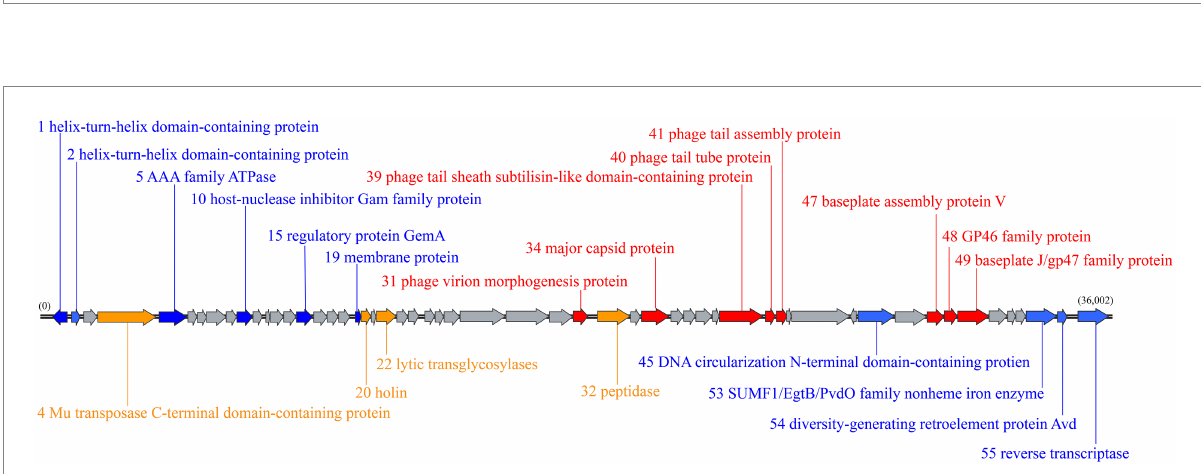
FIGURE 4 Genomic map of YPCBV-1. Gray represents predicted putative protein/DUF family protein genes; orange represents predicted lytic/lysogenic genes; blue represents predicted regulatory genes; and red represents predicted structural